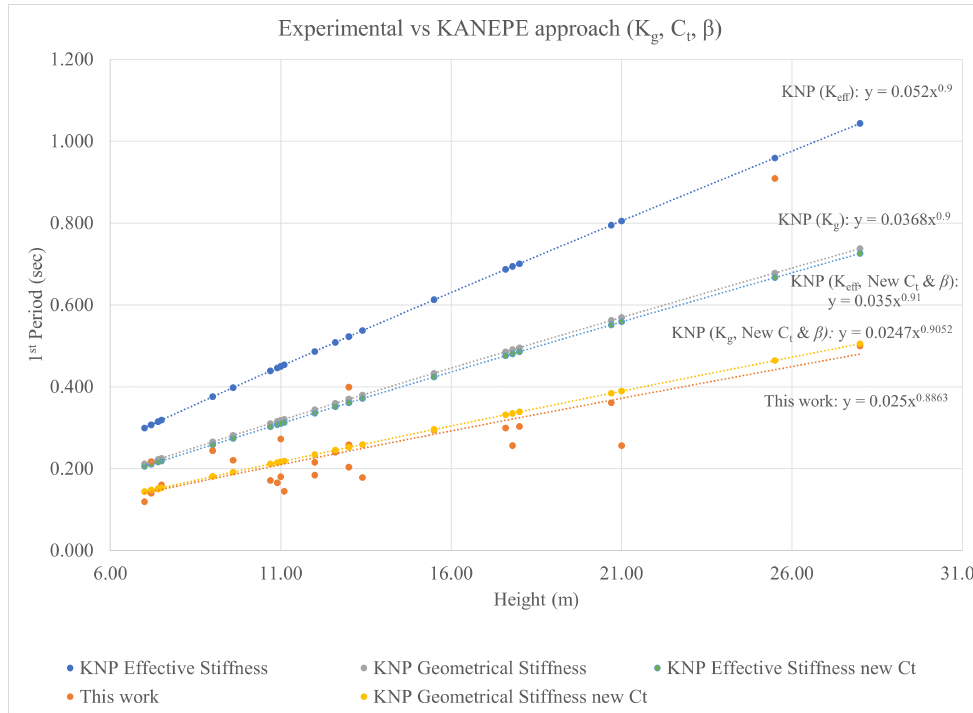
Figure A3. Experimental vs KAN.EPE’s expression ( Kg , C t , β